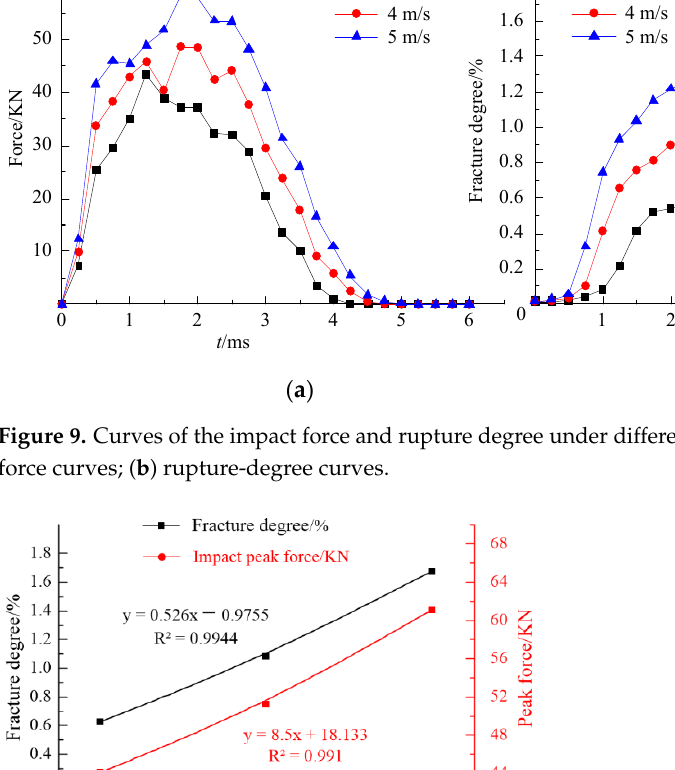
Figure 9. Curves of the impact force and rupture degree under different impact velocities: ( a ) im- pact-force curves; ( b ) rupture-degree curves.